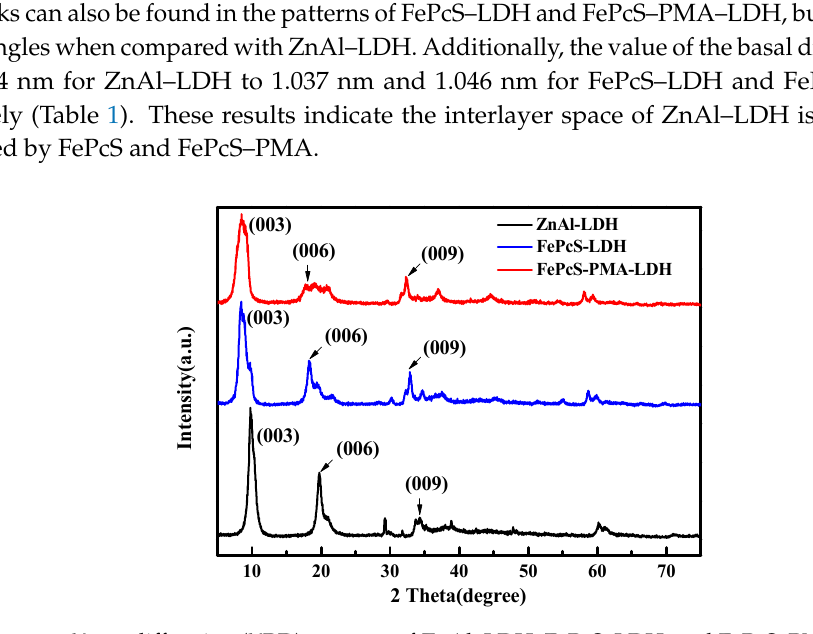
Figure 1. X-ray diffraction (XRD) patterns of ZnAl–LDH, FePcS–LDH, and FePcS–PMA–LDH. Table 1. Basal spacing of ZnAl–LDH, FePcS–LDH, and FePcS–PMA–LDH, determined by the Bragg’s